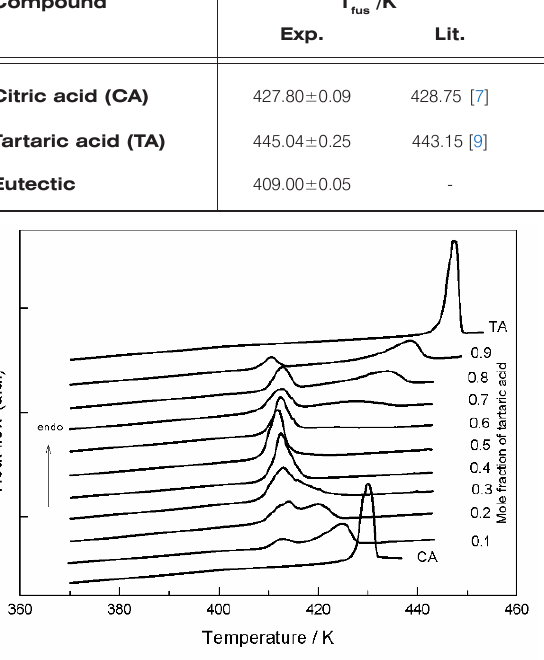
Figure 1. DSC curves at different composition for citric acid (CA) + tartaric acid (TA)